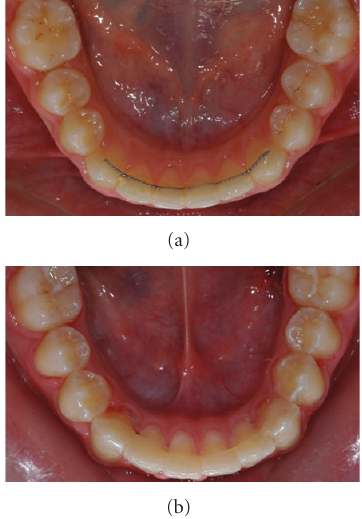
Figure 1: Metallic (a) and FRC (b)